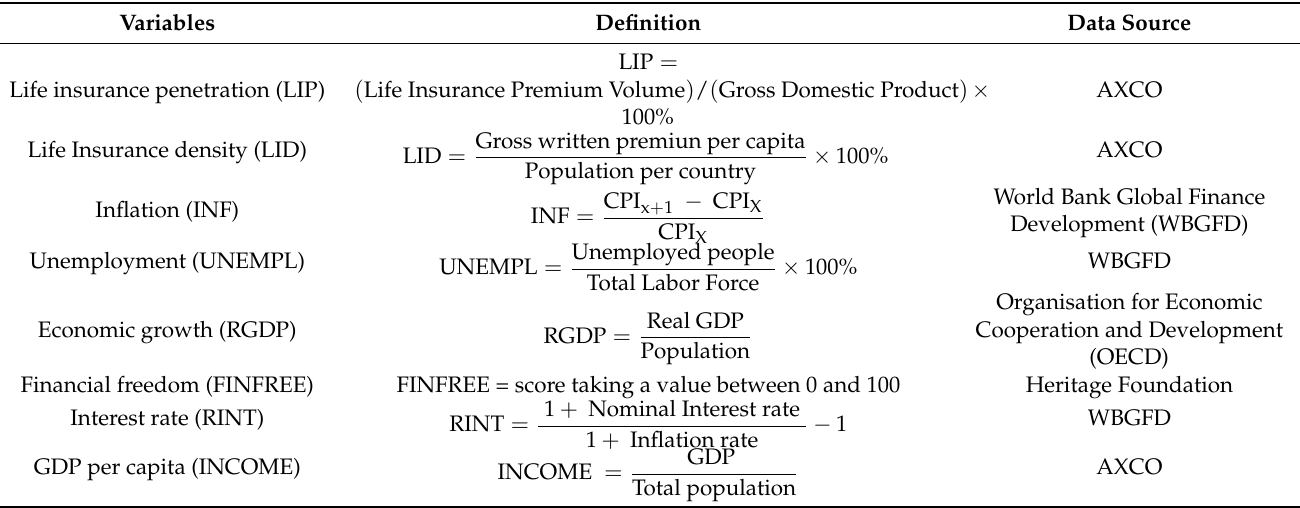
Table 2. Variable definition and data